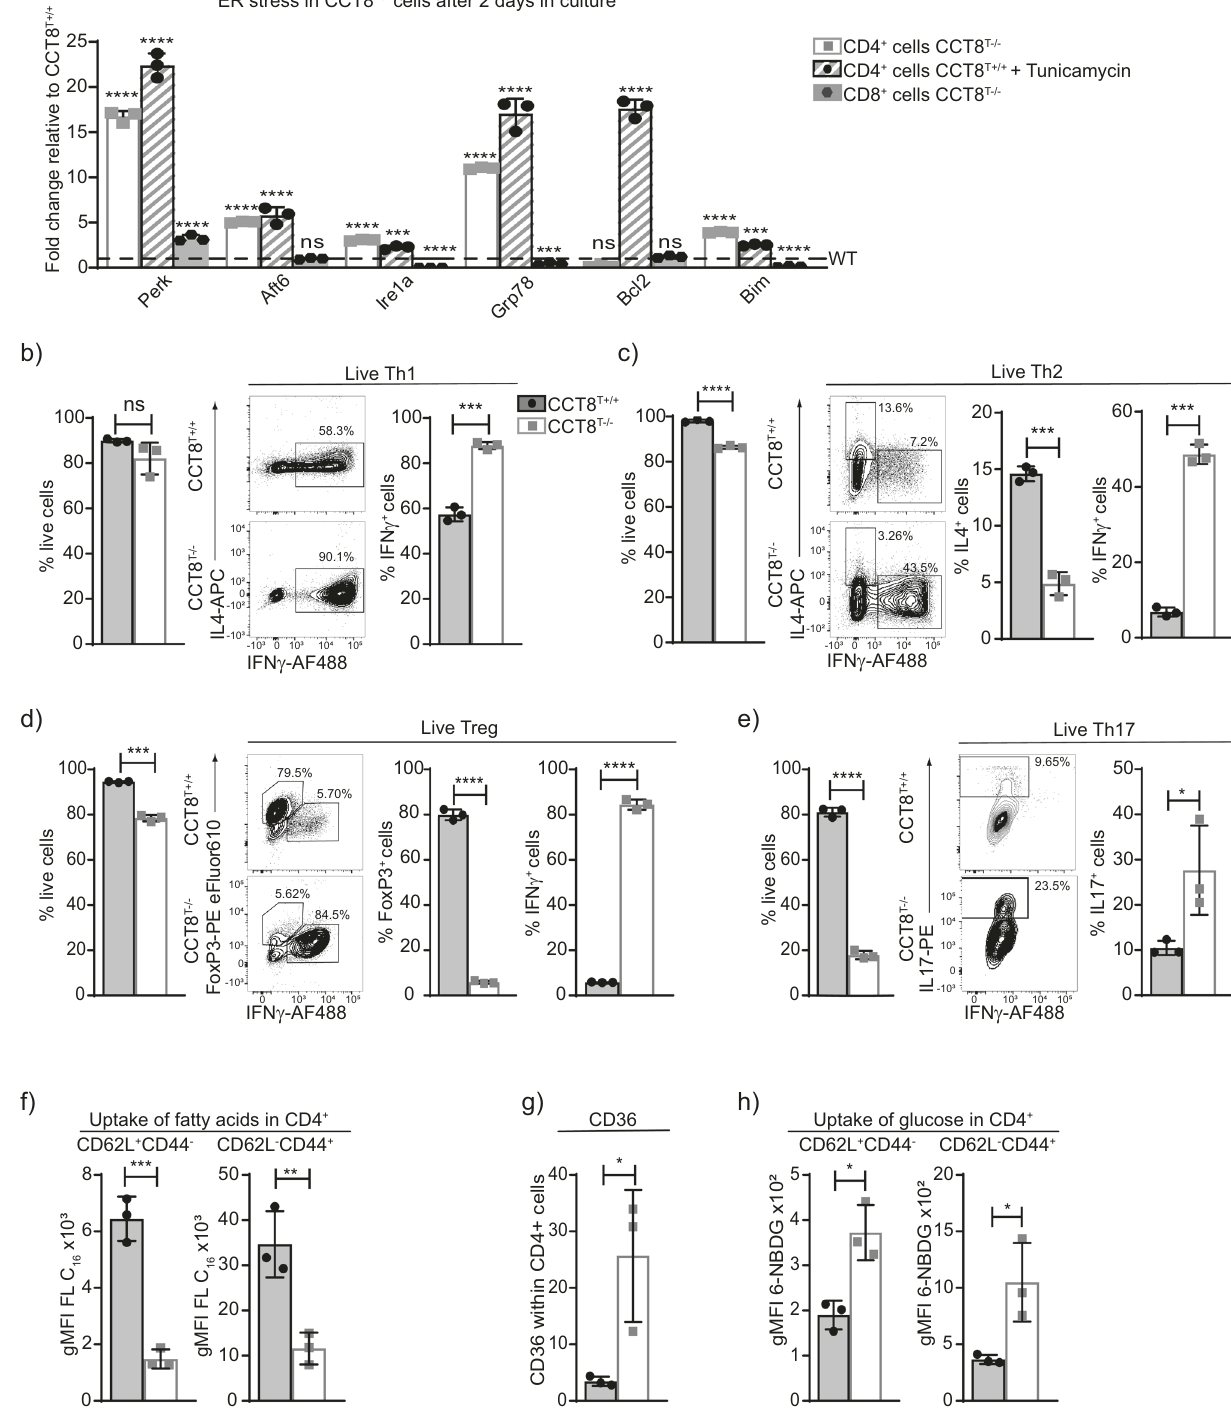
Fig. 4 Peripheral T cell functions in the absence of CCT8 expression. Analysis of naive CD4 + T cells from 4 – 6-week-old CCT8 T + / + (grey bars) and CCT8 T − / − mice (white bars). a qPCR analysis of ER stress response elements in CD4 + and CD8 + T cells activated by CD3 and CD28 cross-linking and cultured in the presence or absence of Tunicamycin (CD4 + cells only); expression normalized to GPDH and displayed as 2 − ΔΔ Ct CT values relative to values from CCT8 T + / + CD4 + and CD8 + T cells arbitrarily set 1. b In vitro differentiation of peripheral naive CD4 + T cells grown for 5 days under differentiating conditions: frequency of live cells (left) and cells (right) adopting: b Th1 polarization; c Th2 polarization; d T reg differentiation; and e Th17 differentiation. f Uptake of fatty acids in CD4 + CD62L + CD44 − (naive) and CD62L − CD44 + (memory) cells ex vivo activated by CD3 and CD28 cross- linking for 20 h. g Expression of long-chain fatty acid receptor CD36 on CD3/CD28-activated cells, and h uptake of glucose analogue 6-NBDG in CD4 + CD62L + CD44 − (naive) and CD62L − CD44 + (memory) cells. * p < 0.05, ** p < 0.01, *** p < 0.001, **** p < 0.0001. Data were calculated by ANOVA correcting for multiple comparisons (Holm-Sidak method) ( a ) and Student ’ s t -test ( b – h ). Bar graphs show mean ± SD and are representative of two independent experiments with three replicates each. See also Fig.